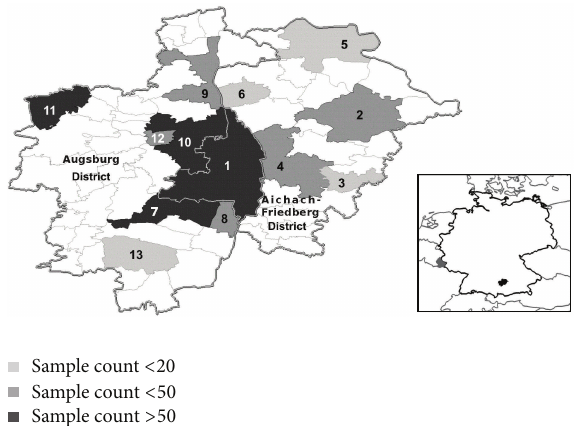
Figure 1: Study area. Land units: (1) Augsburg; (2) Aichach; (3) Eurasburg; (4) Friedberg; (5) P¨ottmes; (6) Rehling; (7) Bobin- gen; (8) K¨onigsbrunn; (9) Langweid (Meitingen); (10) Neus¨aß (Gersthofen; Stadtbergen); (11) Altenm¨unster; (12) Aystetten; (13) Schwabm¨unchen. Location of the study area within Germany is indicated in the inset in black; German boundaries are displayed with a black line, neighboring-country boundaries are displayed with a gray line; Luxembourg, a country covering an extension similar to the study area, located on the western boundary of Germany, is displayed in